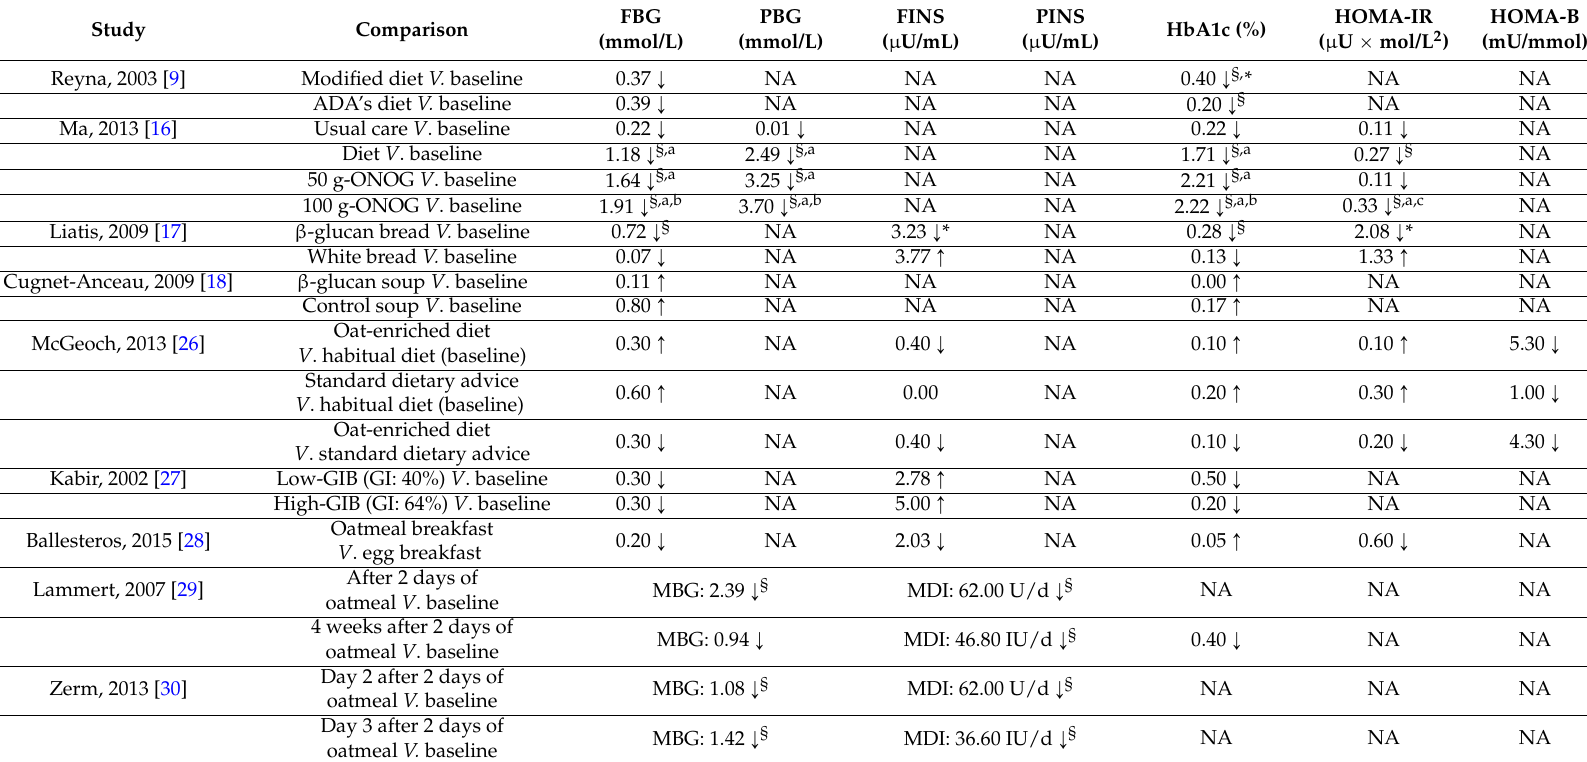
Table 2. Glucose control and insulin